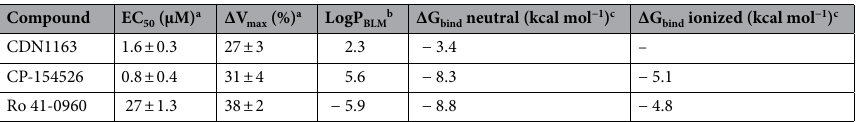
Table 1. Half-maximum effective concentration (EC 50 ), change in ATPase turnover (V max ), partition coefficient, and ligand–lipid free energy of binding of SERCA activators. a Values were obtained from in situ SERCA2a ATPase activity experiments ( n = 3); values are reported as mean ± SEM. b LogP BLM is the permeability coefficient of molecules through the black lipid membrane. c Estimated from the PMF profile of the umbrella sampling calculations.